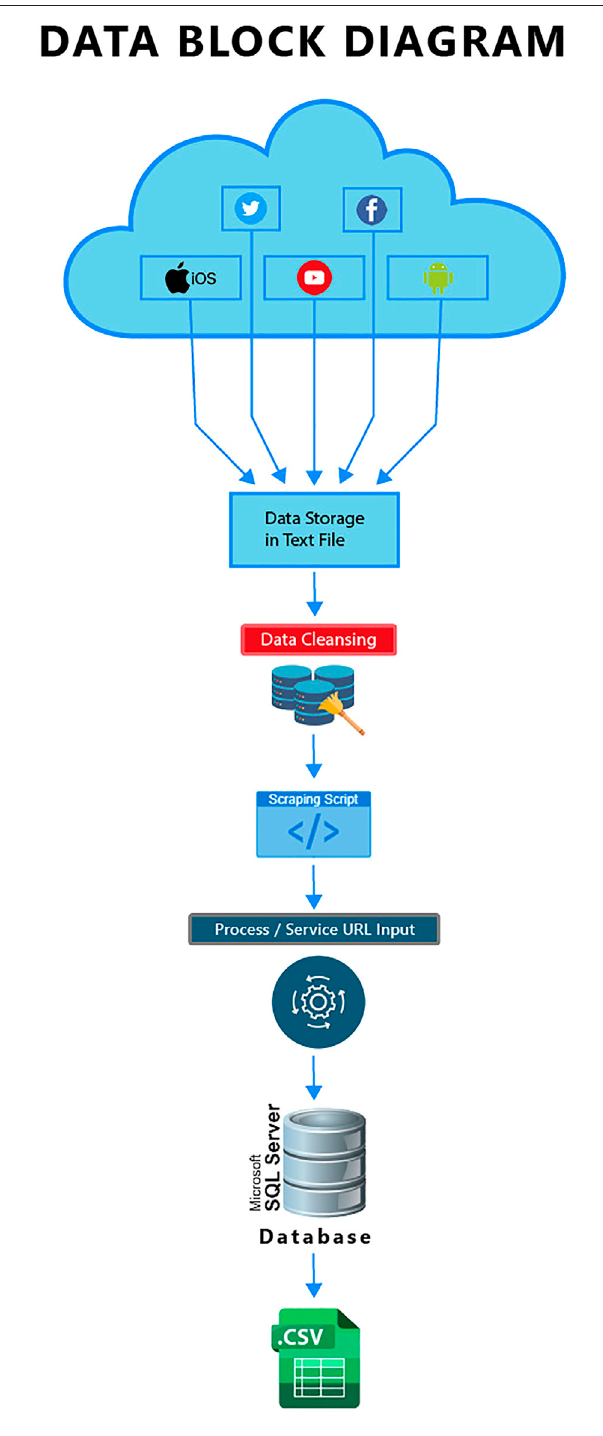
FIGURE 2 | Data scrapping and storage steps.